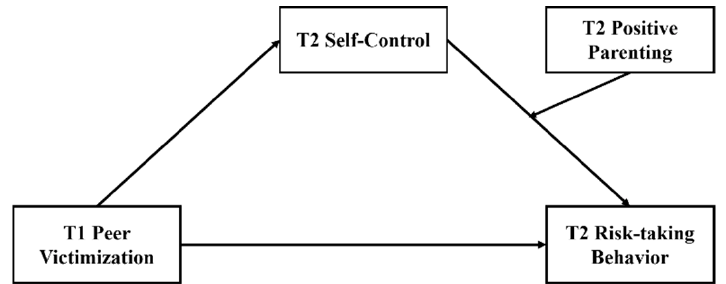
Figure 1. Conceptual Model. Note: T1 = Time 1, T2 = Time 2.